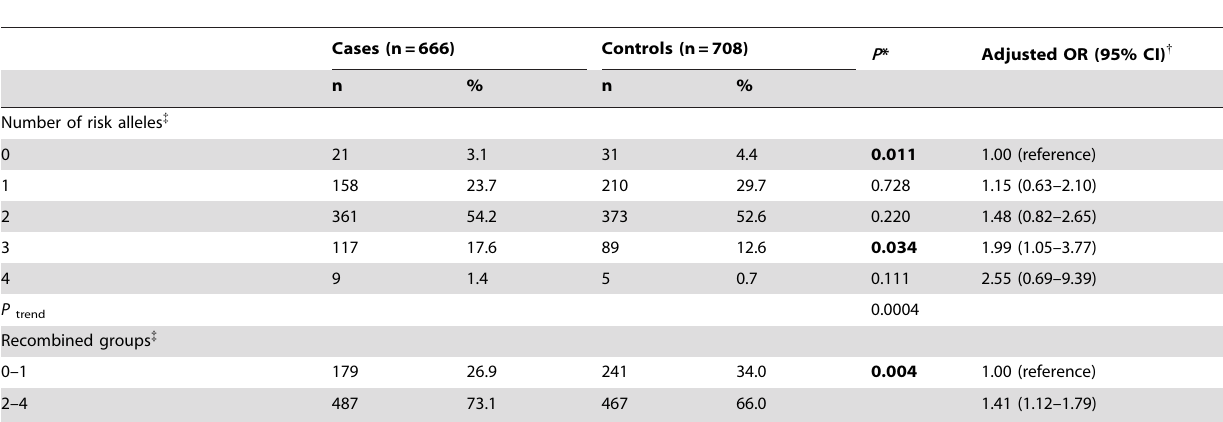
Table 3. Frequency distributions of the combined genotypes of rs2295080 T . G and rs7254617 G . A among the cases and controls, and the correlation to risk of PCa.